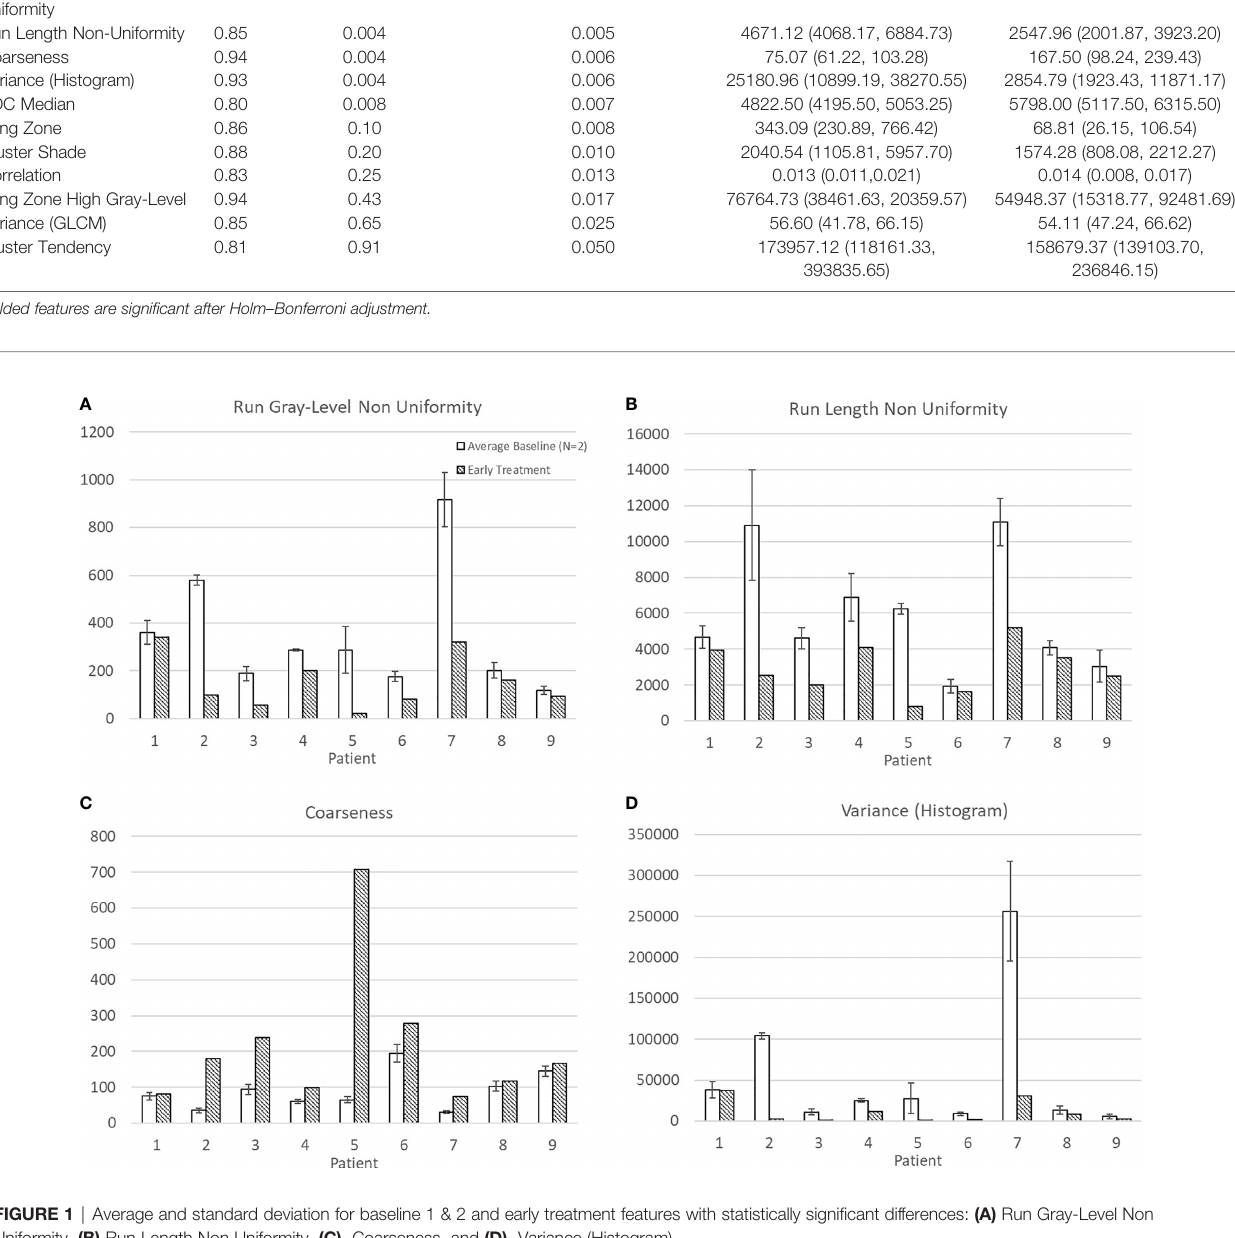
early treatment, indicating a narrower distribution of the ADC values, i.e., more voxels having similar values than they had at baseline ( Figure 1D ). Coupled with the increase in mean ADC values, the ADC values were more homogenous in the early intra-treatment examination.